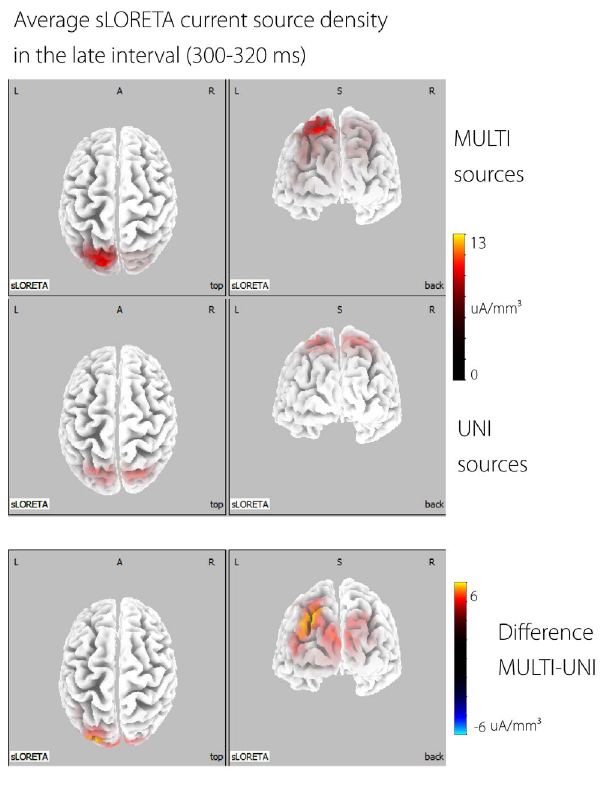
Figure 6. sLORETA source localisation . Current source density ( m A/ mm3) displayed on the MNI Colin-27 T2 template brain for the MULTI (top row) and UNI (bottom row) waves, in the late interval (300–320 ms). The difference between the two (MULTI-UNI) is shown in the bottom row. Four views are shown: from left to right these are top, back, left, and right views.